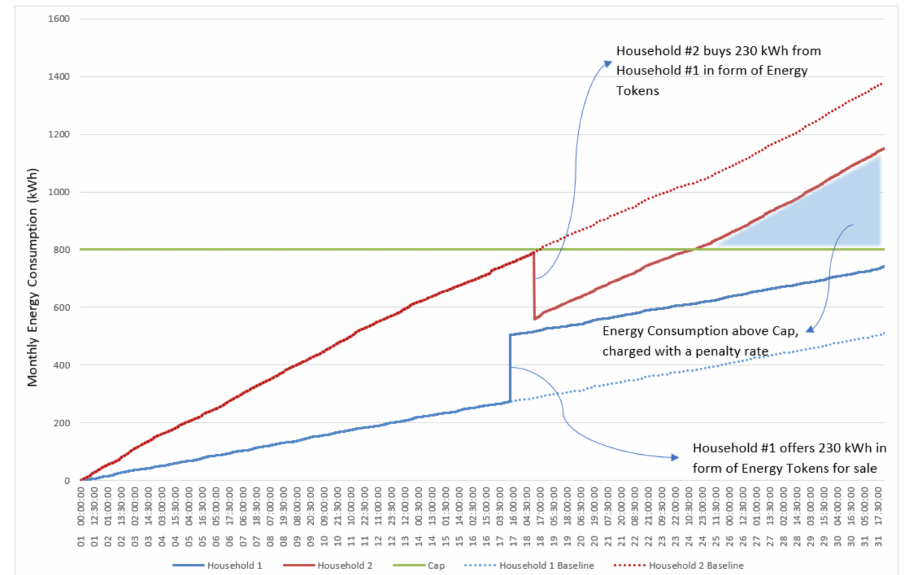
Figure 3. Energy Cap and Trade Energy Consumption